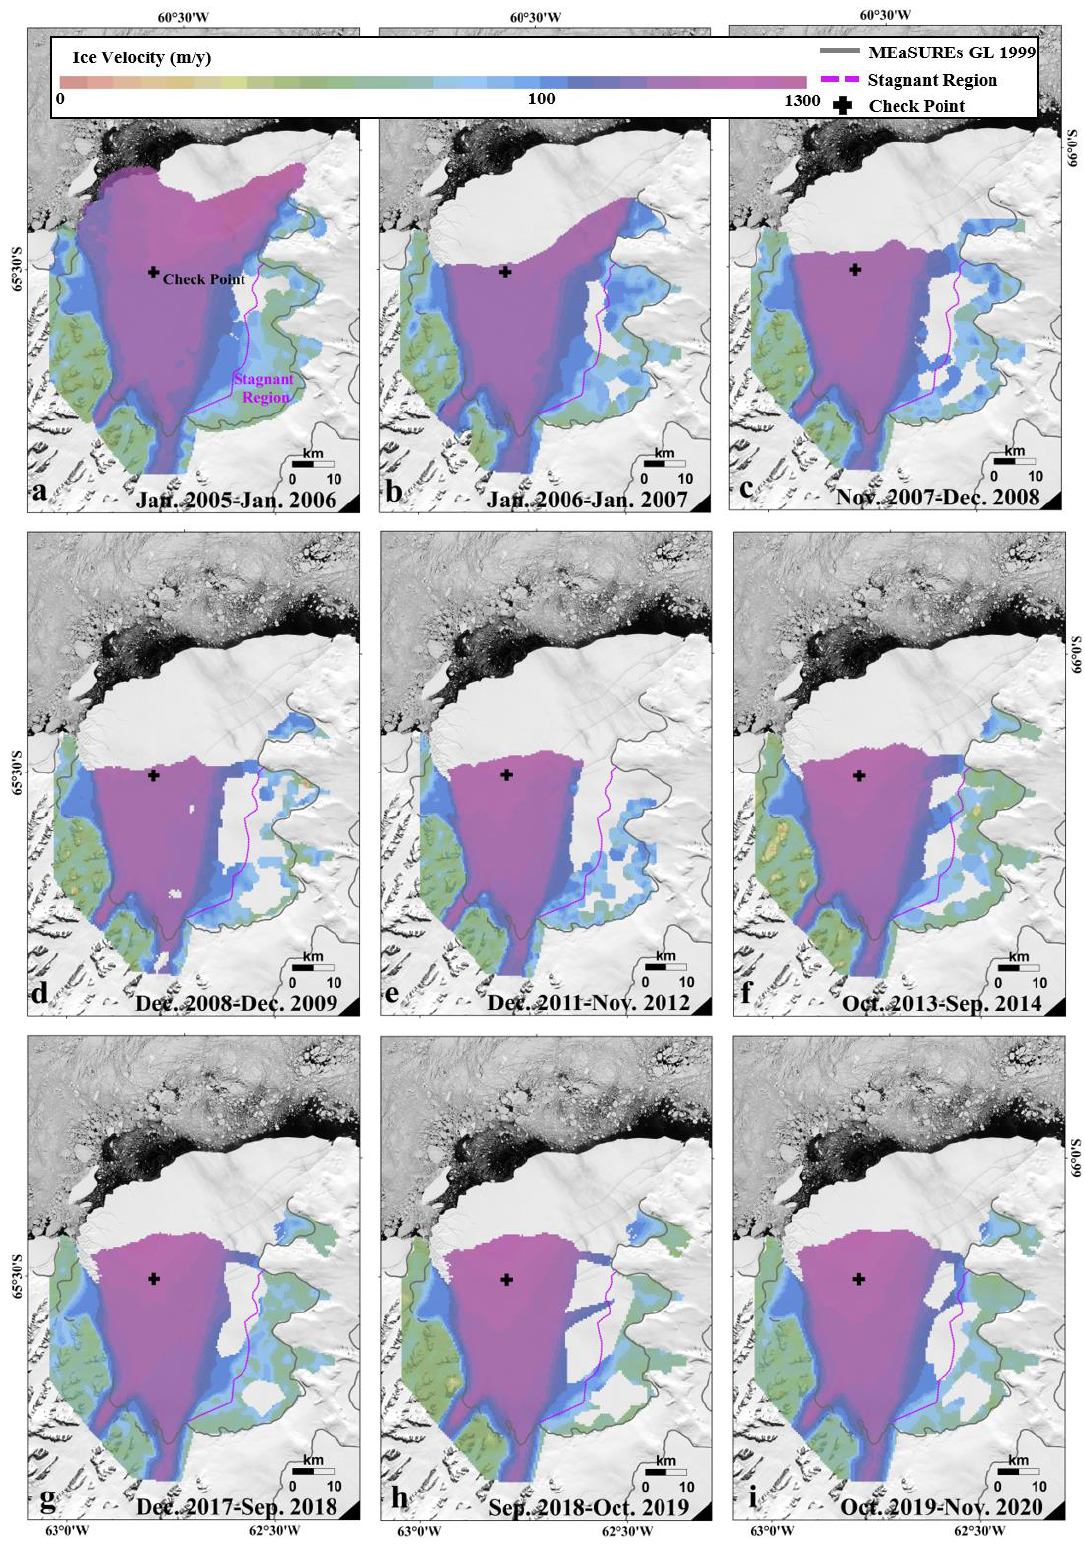
Figure 3 . Ice velocity maps of the Scar Inlet Ice Shelf from 2005 to 2020: (a) Jan. 2005–Jan. 2006, (b) Jan. 2006–Jan. 2007, (c) Nov. 2007–Dec. 2008, (d) Dec. 2008–Dec. 2009, (e) Dec. 2011–Nov. 2012, (f) Oct. 2013–Sep. 2014, (g) Dec. 2017–Sep. 2018, (h)